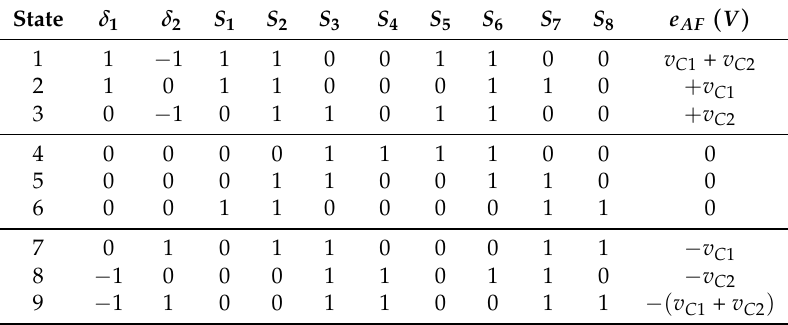
Figure 1. Single-phase SAPF based on a 5L-HB-NPC topology. Table 1. Switching states of the